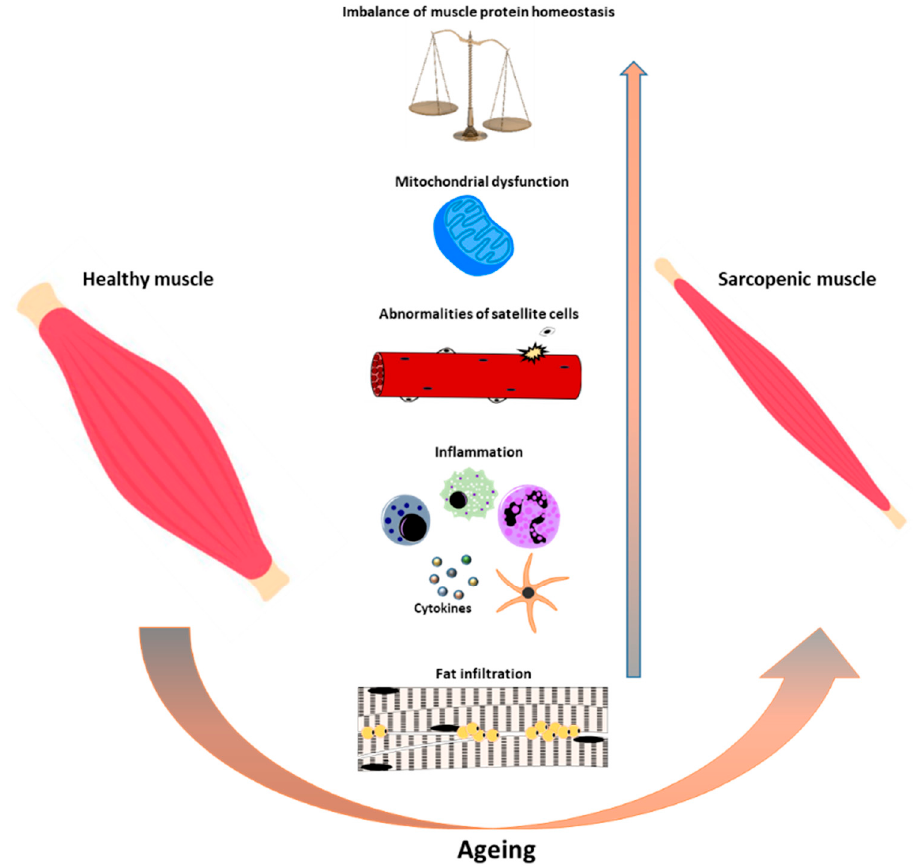
Figure 1. Schematic representation of cellular processes involved in the onset of sarcopenia during ageing. During ageing multifactorial events such as protein synthesis / degradation imbalance, satellite cell number / activity impairment, chronic inflammation, mitochondrial dysfunction, and fat infiltration increase contributing to the onset of